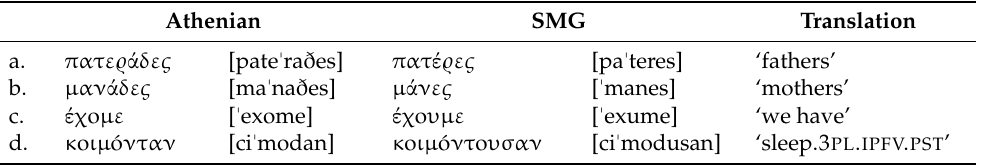
Table 2. Examples of Athenian features in the speech of